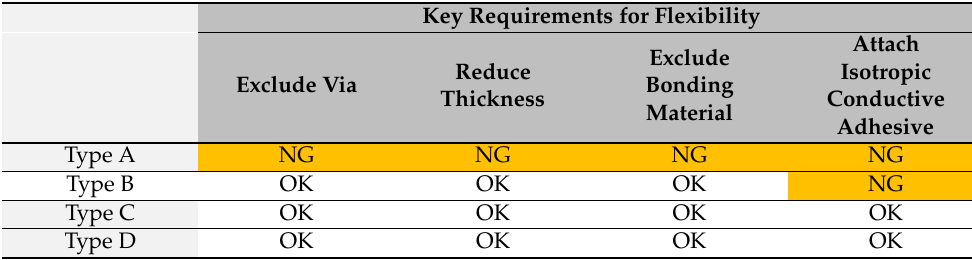
Figure 9. Comparison of major differences between FPCB structure types.